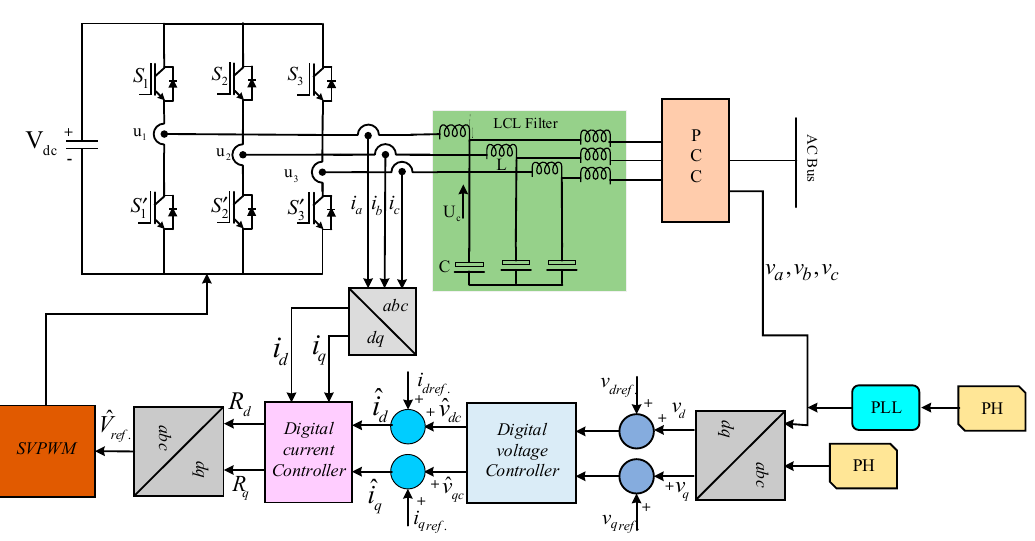
Figure 10. Schematic diagram of a controlled three-phase grid connected VSI with a digital controller.